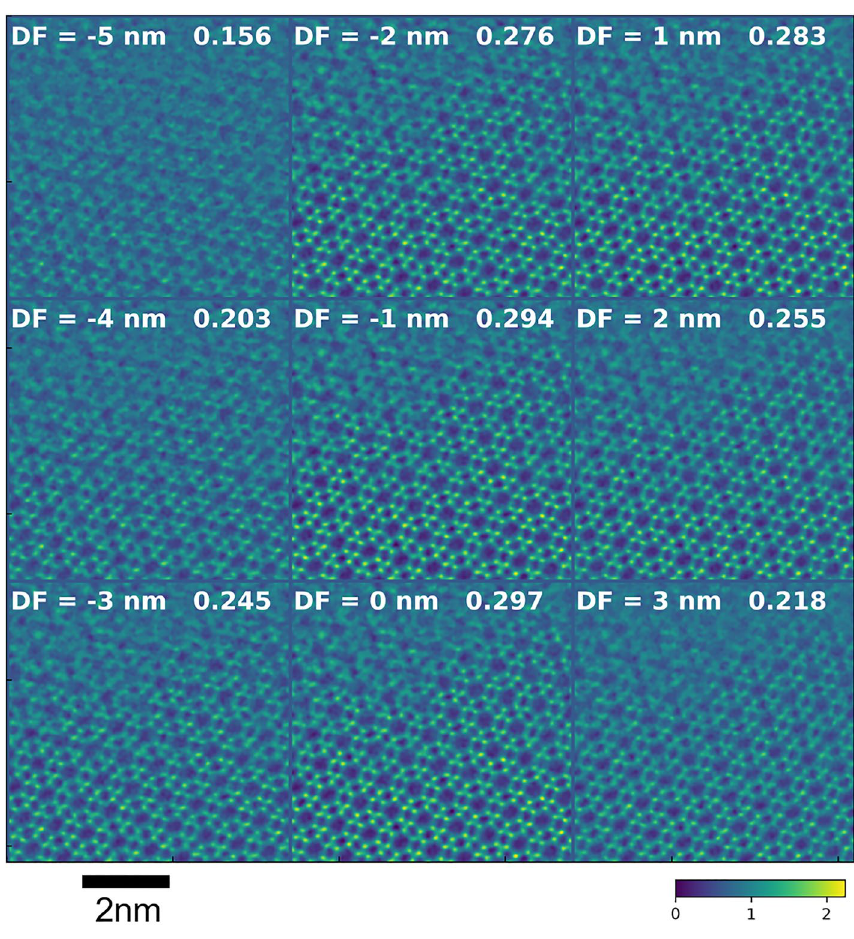
Figure 6. Experimental images of Cu-free CHA reconstructed with defocus ranging from − 5 to 3 nm. The number at the top right of each image is the standard deviation of the